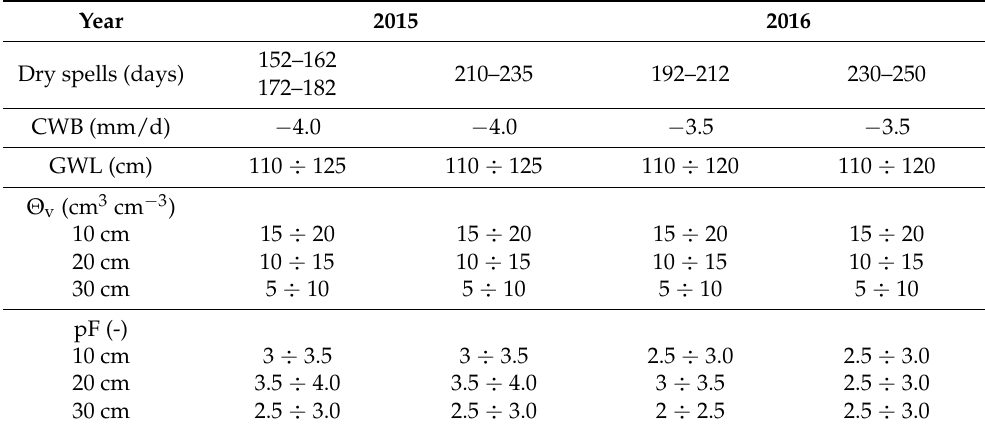
Table 3. Approximate values of the climatic water balance (CWB), ground water level (GWL), soil moisture content ( θ v), and soil water potentials (pF) at consecutive depths of the soil root zone during dry spells of